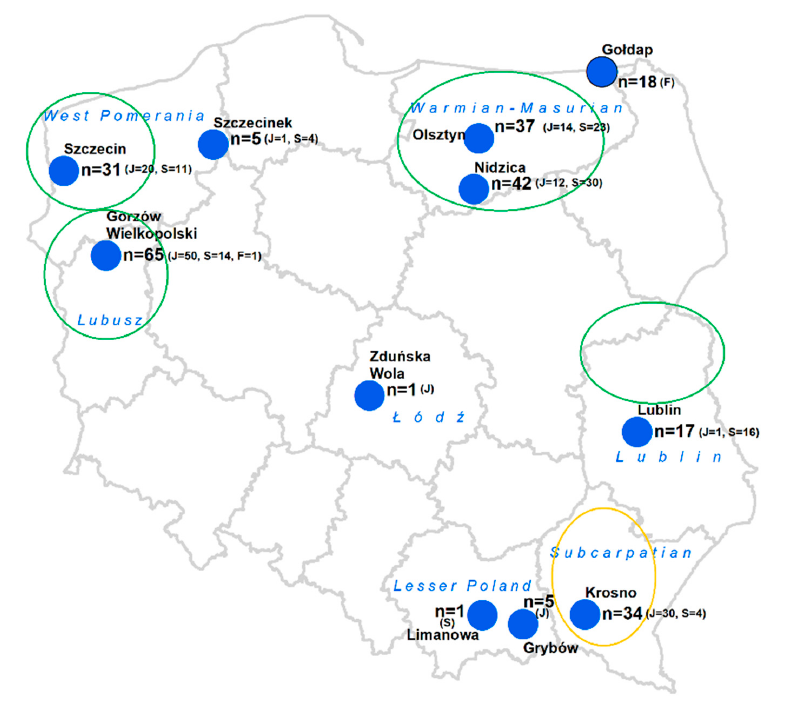
Figure 1. Geographic distribution of samples collected from wild deer in Poland. Blue dots show the areas of the samples collection which correspond to closest cities, n—the number of samples collected in the particular areas. F—no. of fallow deer, J—no. of red deer, S—no. of roe deer; green rings—the major regions of dairy cow production in big farms; orange ring—regions with moderate dairy cow production, mainly in small family farms.